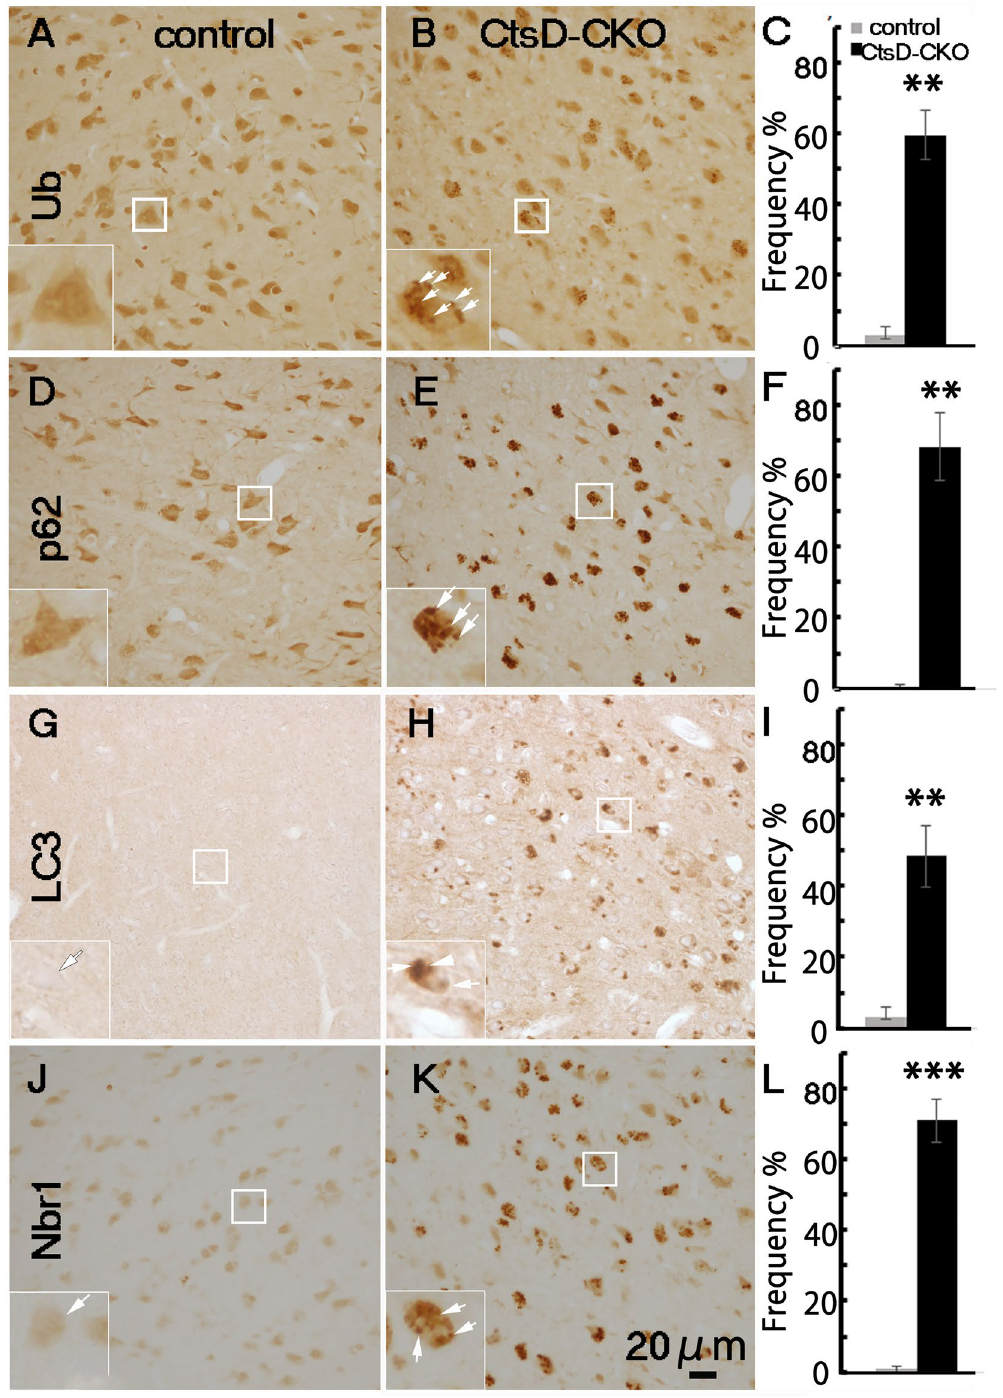
Figure 3. Increase of autophagy-related proteins expression in thalamus of CtsD-CKO mice. Immunohistochemical staining of ubiquitin (Ub) ( A , B ), p62 ( D , E ), LC3 ( G , H ) and Nbr1 ( J , K ) in thalami of CtsD-CKO ( B , E , H , K ) and control littermate ( A , D , G , J ) mice at p25. Insets show enlarged boxed areas of neuronal cells in the thalamus of CtsD-CKO that possess immuno-positive granules (arrows). Scale bar; 20 µm. The numbers of cells possessing ubiquitin ( C ), p62 ( F ), LC3 ( I ) and Nbr-1 ( L ) positive granules in the thalamus were quantified. Immunostained brain sections form CtsD-CKO mice were compared with age-matched control littermate mice. (**p < 0.03, ***p < 0.001, from p19 to p25, All data were obtained from three sections form 3 separate mice. Over 72 cells per each section were